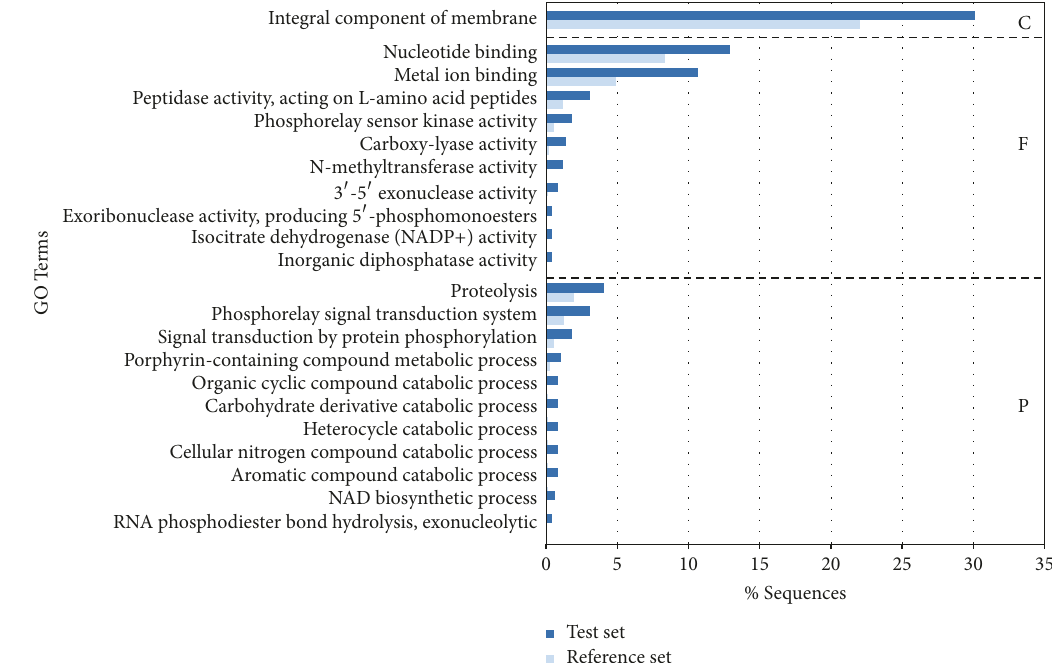
Figure 3: GO enrichment analysis for the subtype A genes accumulating high-impact mutations . The analysis was conducted with the genes from the type A specimens having at least one mutation of predicted high impact (test set) and their corresponding orthologs from strain JB197 (reference set). Plot shows GO terms found to be overrepresented with a 푝 value below 0.05, ordered by percent sequences in descending order and grouped by GO class (C: cellular components, F: molecular functions, and P: biological